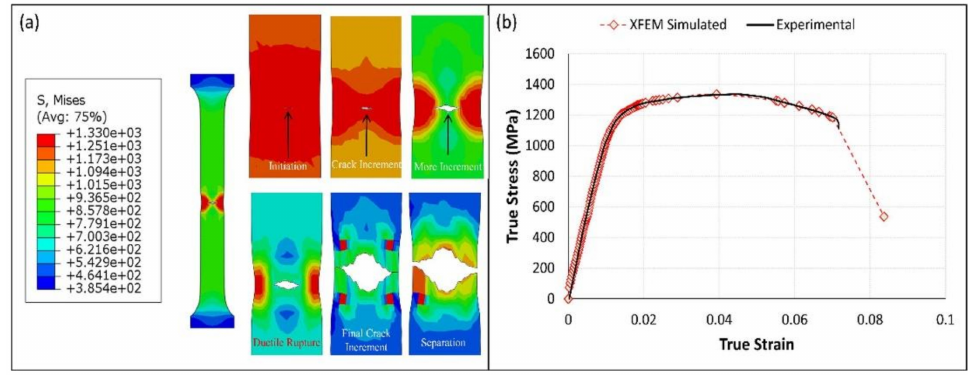
Figure 25. XFEM simulation ( a ) crack behavior and ( b ) well agreeing simulated- experimental tensile stress flow curve. Reprinted with permission from ref. [84]. 2020, John Wiley.